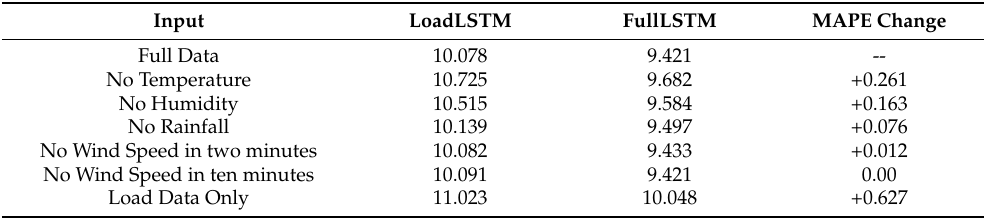
Table 6. Comparison of prediction results in terms of changes in MAPE (%) for different input data in the Chinese dataset.